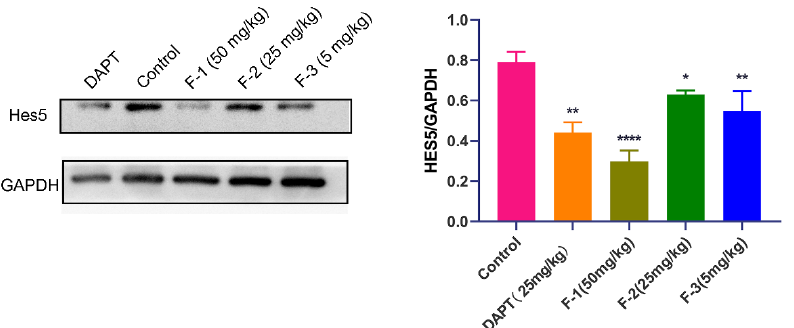
Figure 10. Relationship between in vivo anti-tumor activity of fidaxomicin and the inhibition in Notch signaling in 4T1 tumors. Western blot analysis of protein levels of Notch targets Hes5 in 4T1 tumors was performed after administration with saline, DAPT (25 mg/kg), fidaxomicin (50 mg/kg), fidaxomicin (25 mg/kg), and fidaxomicin (5 mg/kg). Data shown represent the mean ± SD of tripli- cate experiments (* p < 0.05, ** p < 0.01, and **** p < 0.0001 vs. control group).